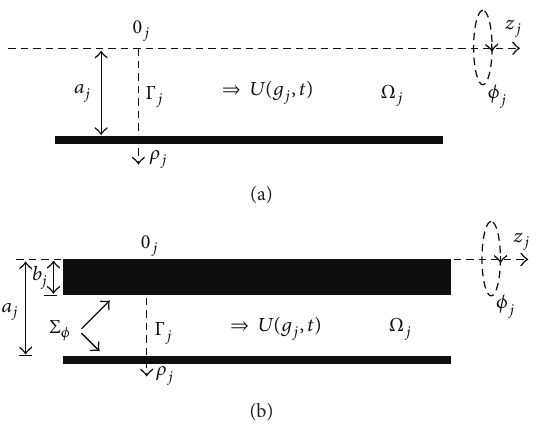
Figure 2: Virtual boundary Γ 𝑗 in the regular (a) circular and (b) coaxial waveguide Ω 𝑗